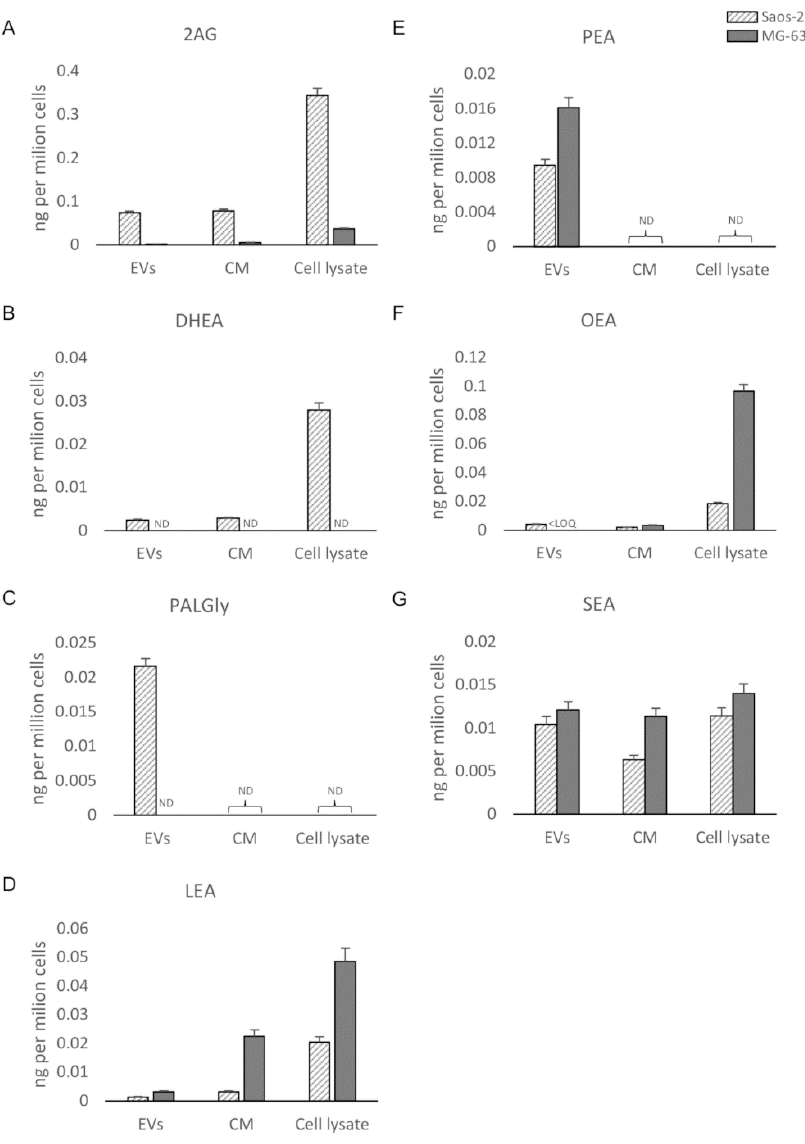
Figure 6. UHPLC-MS / MS quantitation (ND = not detectable; LOQ = limit of quantitation) in EVs, CM, and cell lysate from Saos-2 and MG-63 cell lines of ( A ) 2-arachidonoylglycerol (2AG); ( B ) N -docosahexaenoylethanolamide (DHEA); ( C ) N -palmitoylglicine (PalGly); ( D ) N -linoleoylethanolamide (LEA); ( E ) N -palmitoylethanolammide (PEA); ( F ) N -oleoylethanolamide (OEA); ( G ) N -stearoylethanolamide (SEA).